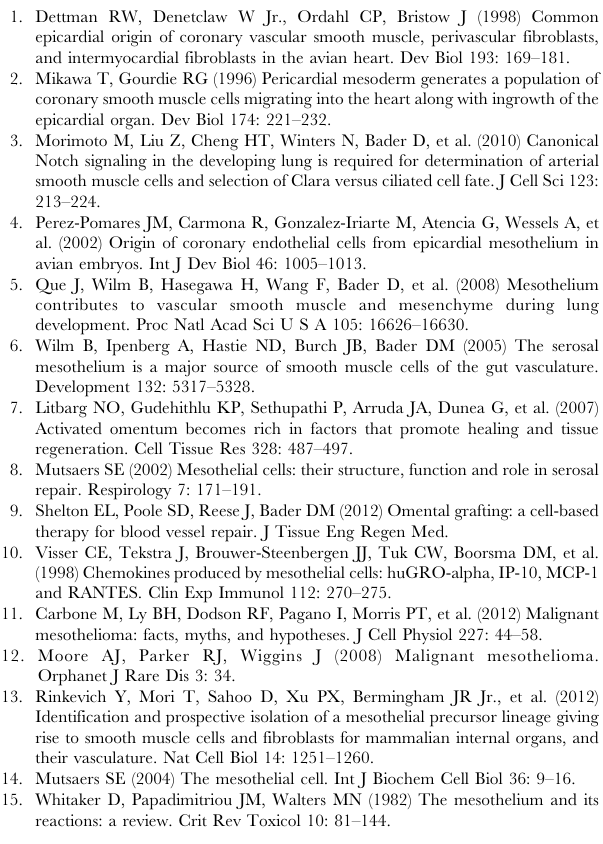
Table S1 Examples of genes differentially expressed in visceral and parietal mesothelia. Positive fold differences indicate higher expression in visceral mesothelium and negative fold differences indicate lower expression in visceral mesothelium compared to parietal